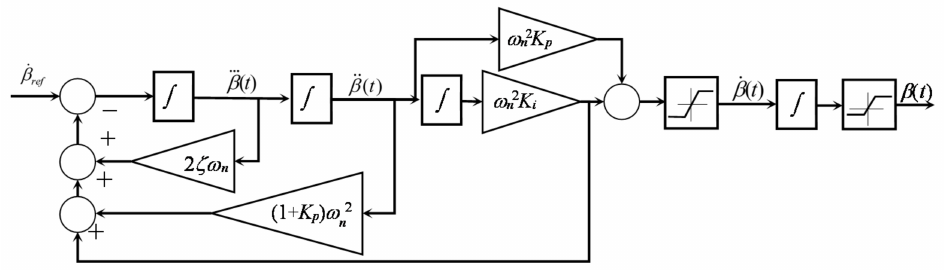
Figure 21. Second order pitch actuator with PI control and pitch rate set